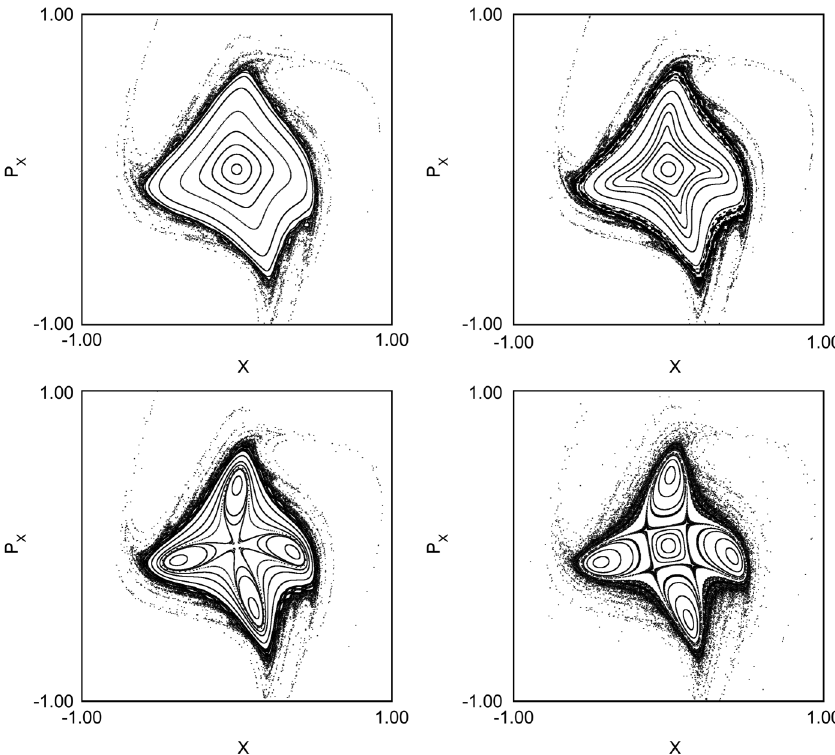
FIG. 2. Phase portrait of the dynamical system described by Eq. (3) as the linear tune (cid:2) is changed and approaching the resonant value (cid:2) ¼ 1 = 4 from